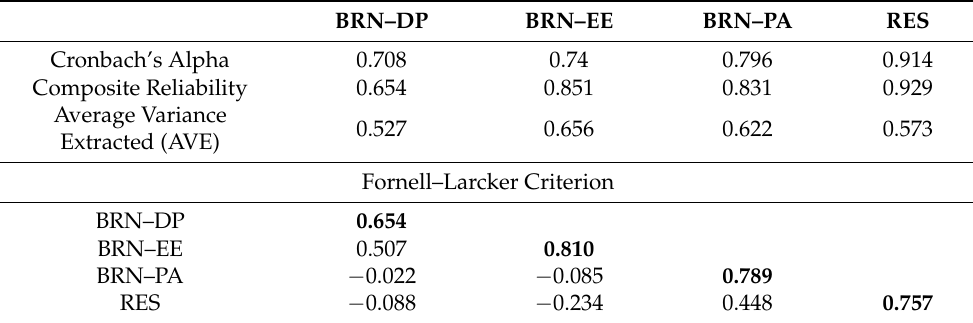
Table 2. Validation measures of the PLS model.